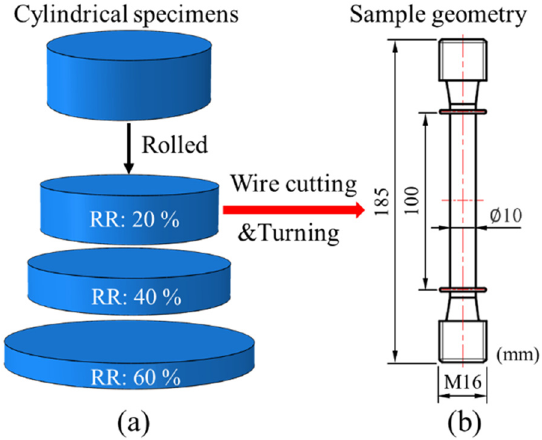
Figure 1: ( a ) Cold - rolled pure iron plates; ( b ) dimension of the stress relaxation test samples.